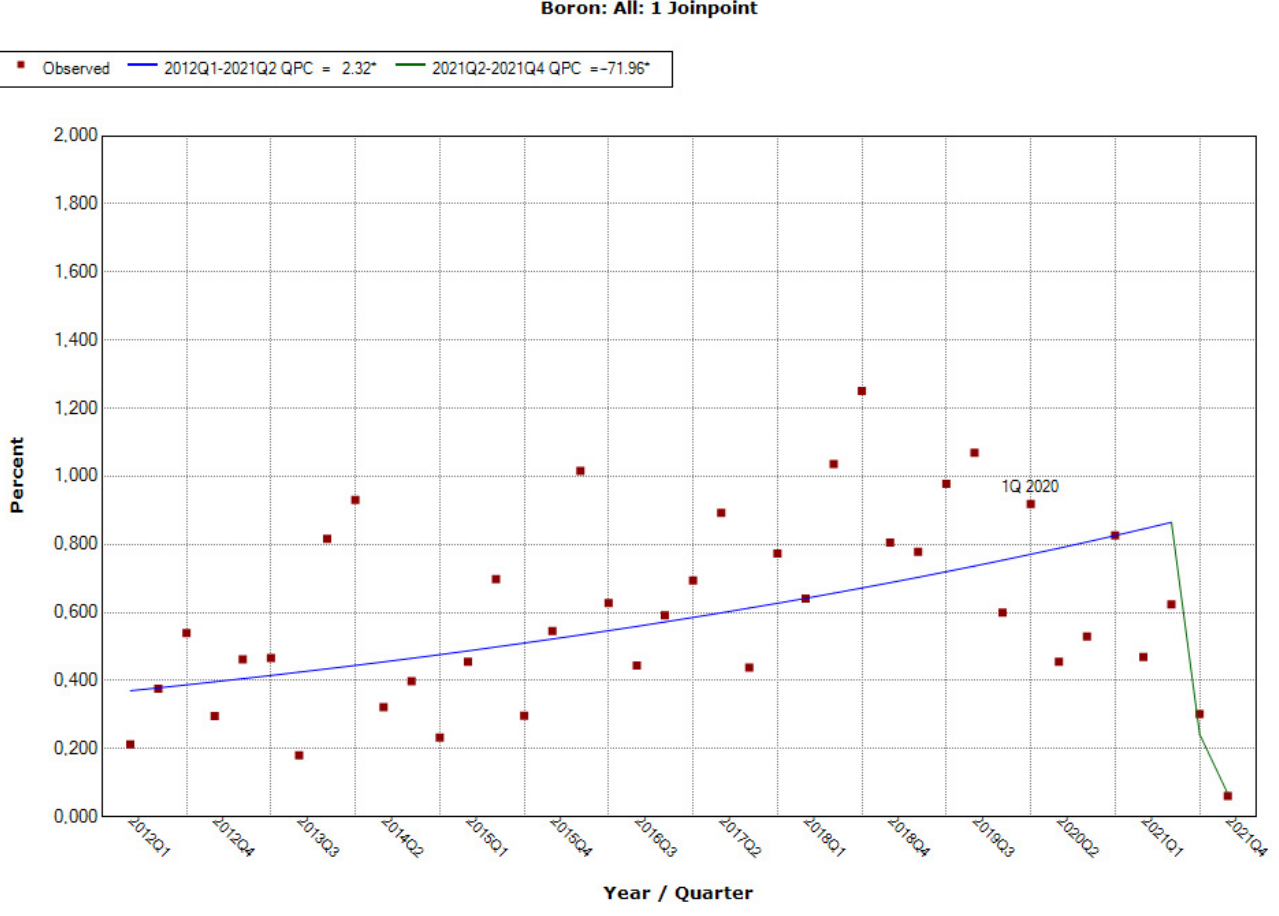
Figure A16. Percentage of products containing boron in individual quarters in the period from 2012 to 28 November 2021. Joinpoints mark trend turning points. The date above the observation indicates the moment of publication of the scientific opinion/resolution.